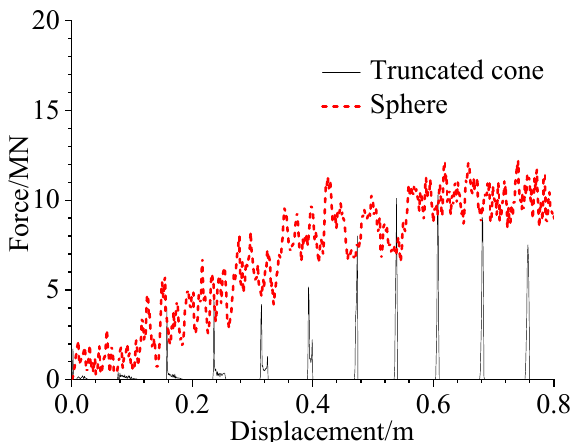
Figure 18. Time history force between ice sphere and rigid plate obtained from the simulations.